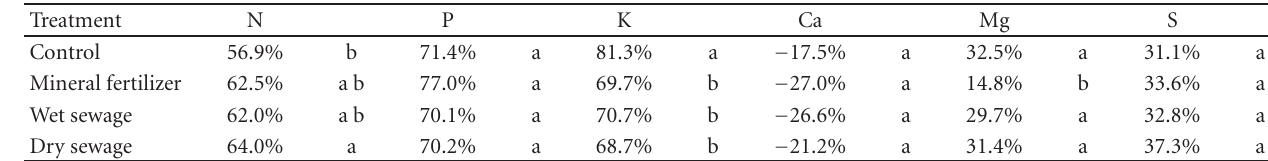
Table 6: Nutrient retranslocation (%) in senescent leaves during 1 to 3 years after planting.